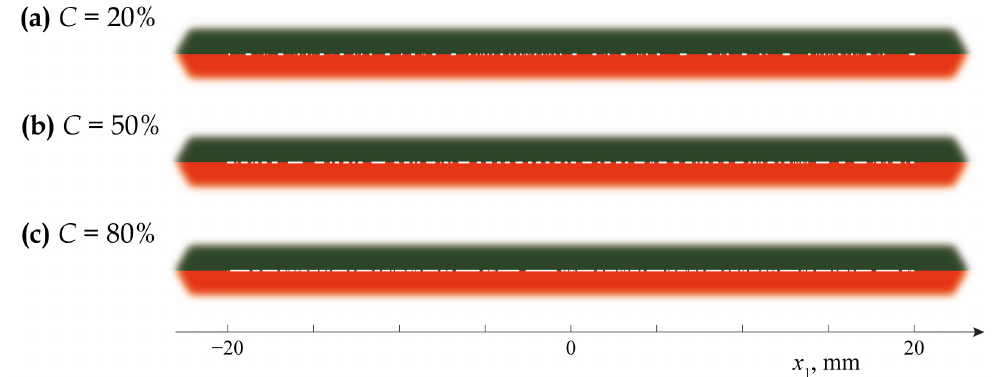
Figure 4. Examples of generated crack distributions for uniform partially closed delaminations with various densities: C = 0.2 ( a ), C = 0.5 ( b ), C = 0.8 ( c